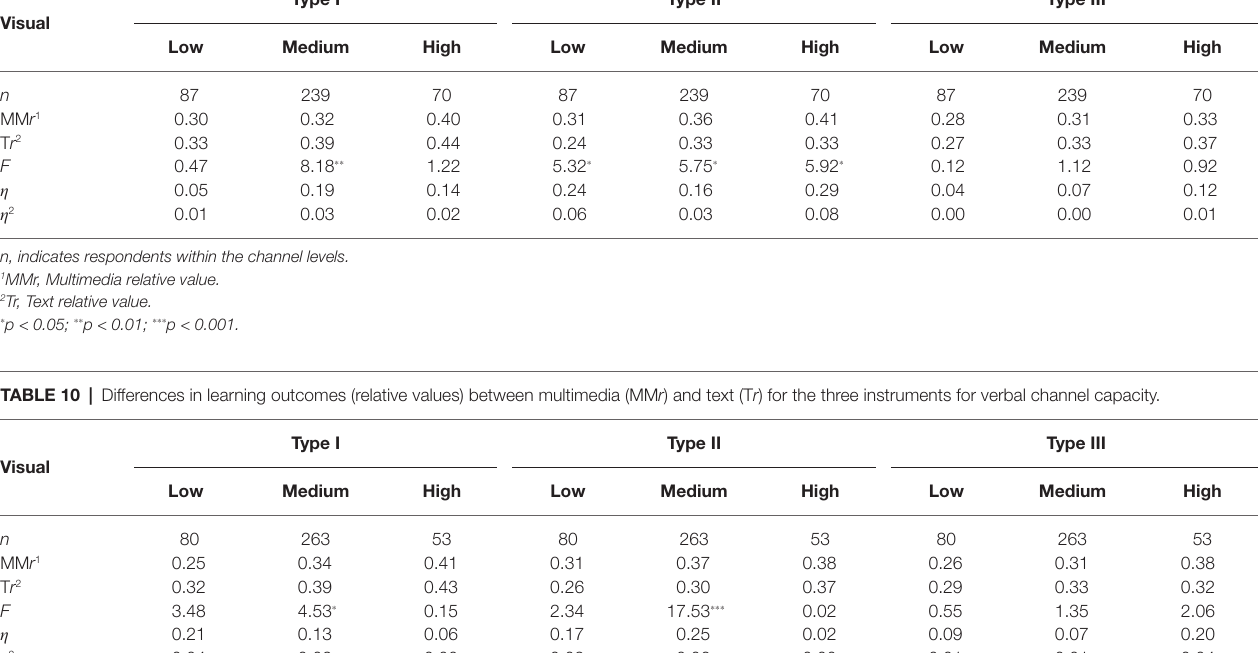
TABLE 9 | Differences in learning outcomes (relative values) between multimedia (MM r ) and text (T r ) for the three instruments for visual channel capacity. Type I Type II Type III Visual Low Medium High Low Medium High Low